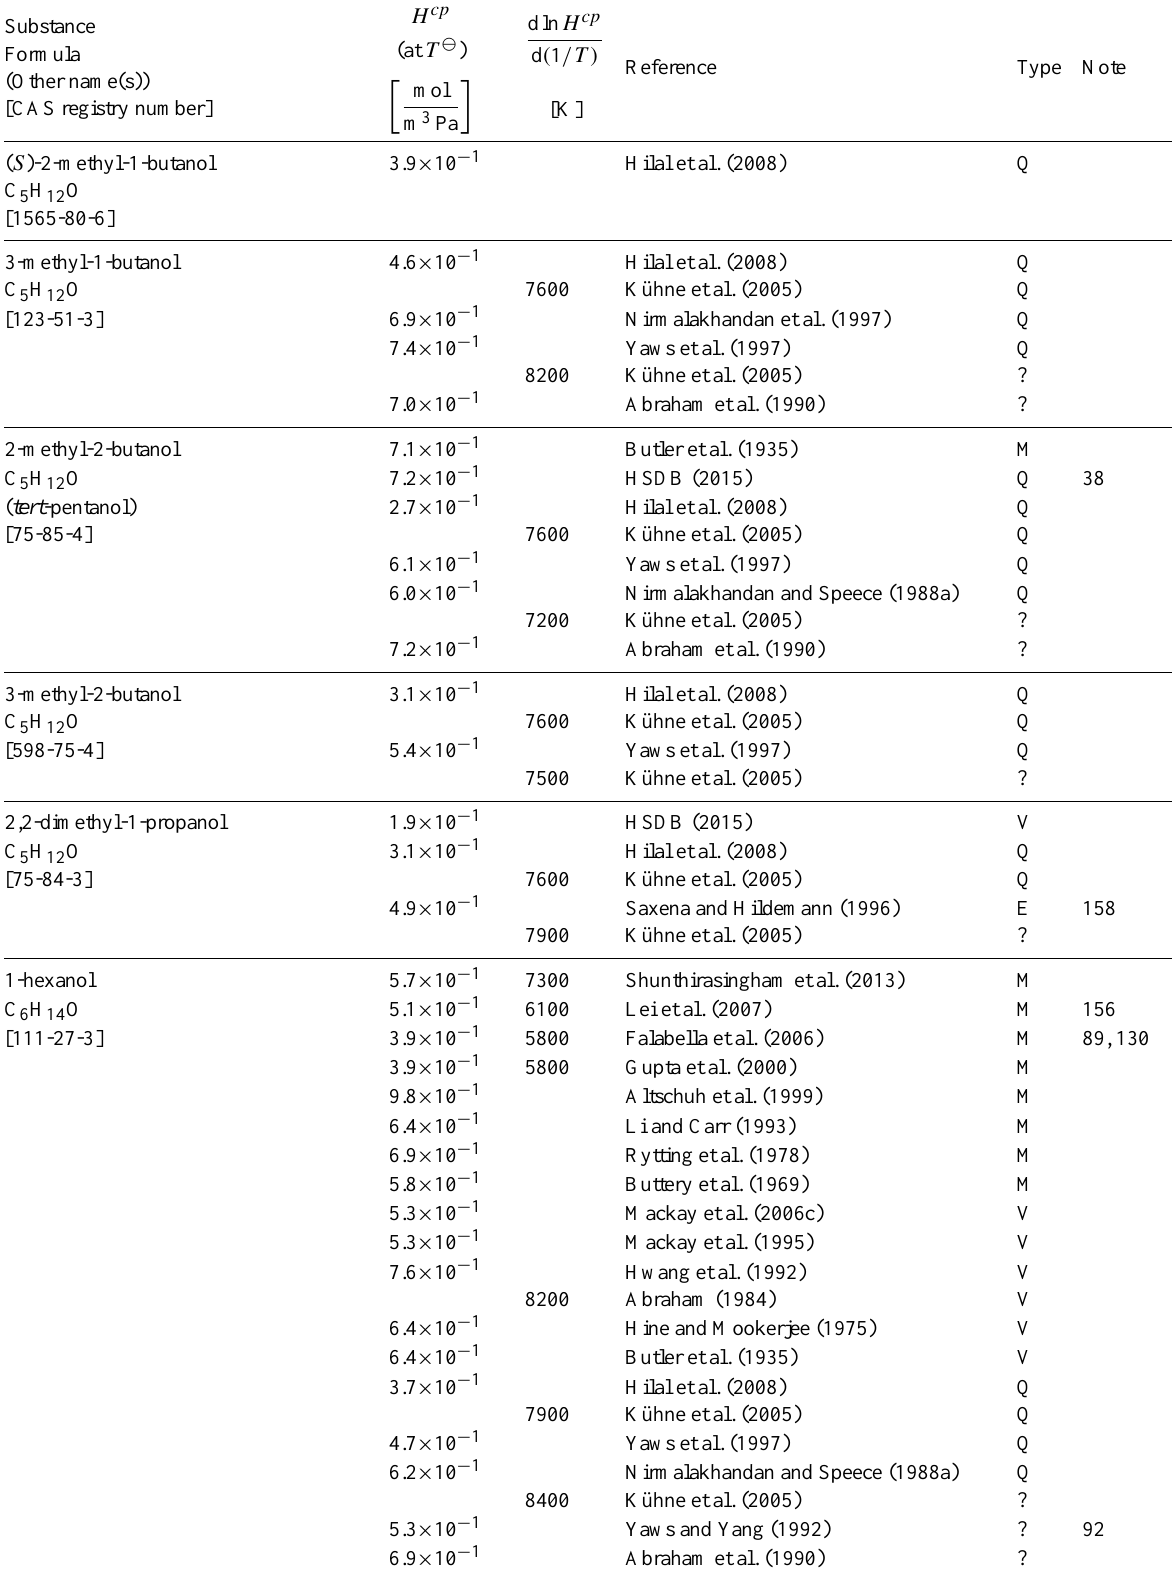
Table 6: Henry’s law constants for water as solvent